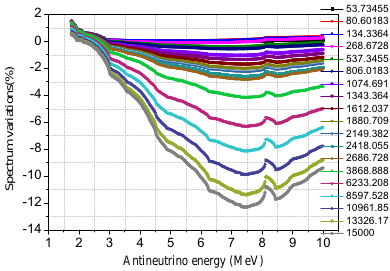
Figure 3. The spectra di ff erence comparison with the spectra of beginning of cycle varying with fuel burnup for the method-3